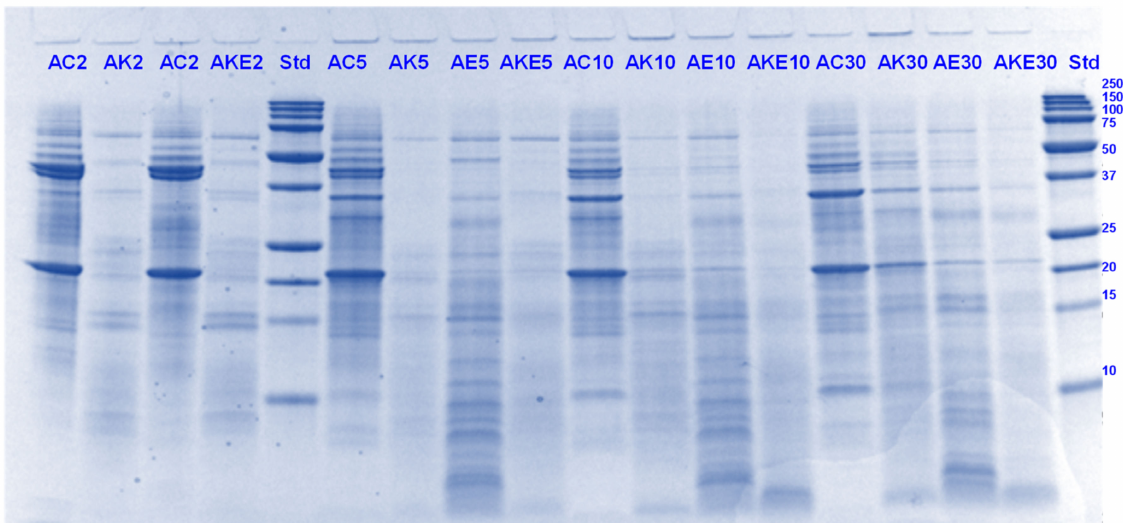
Figure 11. Tricine SDS-PAGE electrophoretogram of almond (A) digests after 2, 5, 10, and 30 min of simulated oral gastric digestion in the presence or absence of Hayward (K) kiwifruit extract. AC, almond (A) control without any digestive enzymes; AK, with added green kiwifruit extract but no digestive enzymes; AE, with digestive enzymes but no added kiwifruit extract; AKE, with both digestive enzymes and green kiwifruit extract. Numbers 2, 5, 10, and 30 are gastric digestion times following 2 min of oral digestion. Bands (1–10) in the molecular weight standard lane correspond to